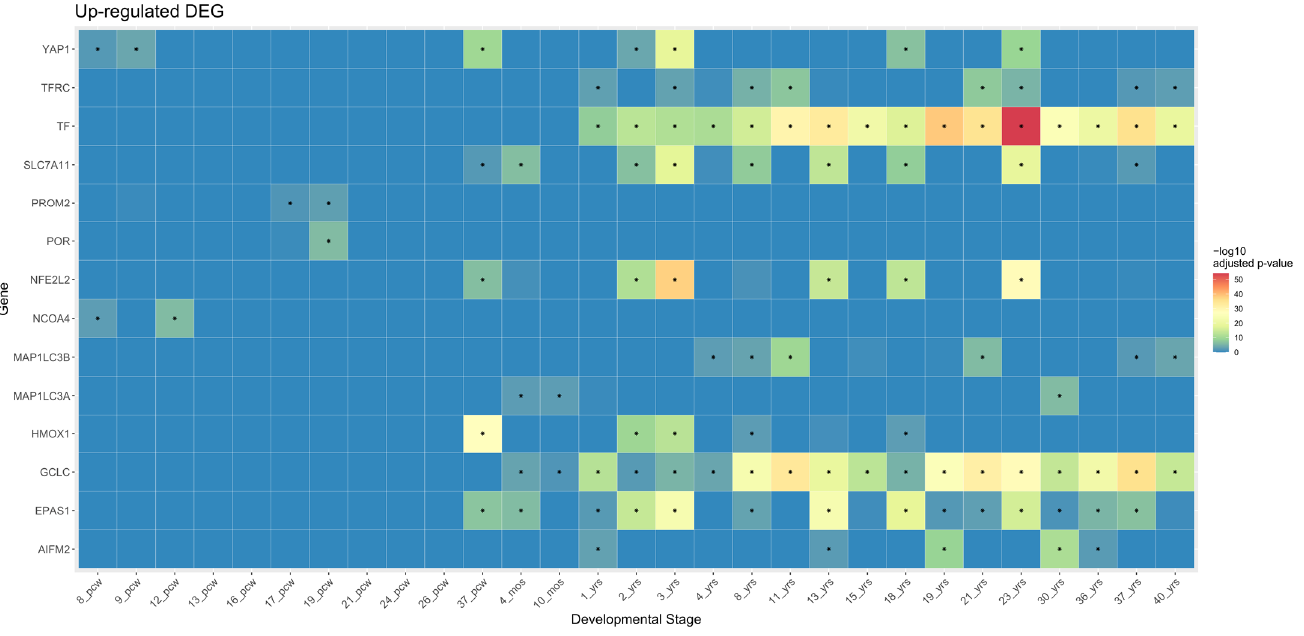
Figure 2. Heatmap of upregulated ferroptosis genes tested against BrainSpan developmental stage. A total of 14 ferroptosis (FR) gene sets displayed significant temporal enrichment in BrainSpan data: NCOA4, POR, PROM2, AIFM2, TFRC, MAP1LC3B, MAP1LCA, HMOX1, YAP1, NFE2L2, SLC7A11, TF, EPAS1 , and GCLC . These are gene sets with FR genes from module groups 2, 3, and 5. Statistically significant results ( − log 10 adjusted p -value ≤ 0.05) are marked with stars (*). Abbreviations: pcw, post conceptional weeks; mos, postnatal months; yrs, postnatal